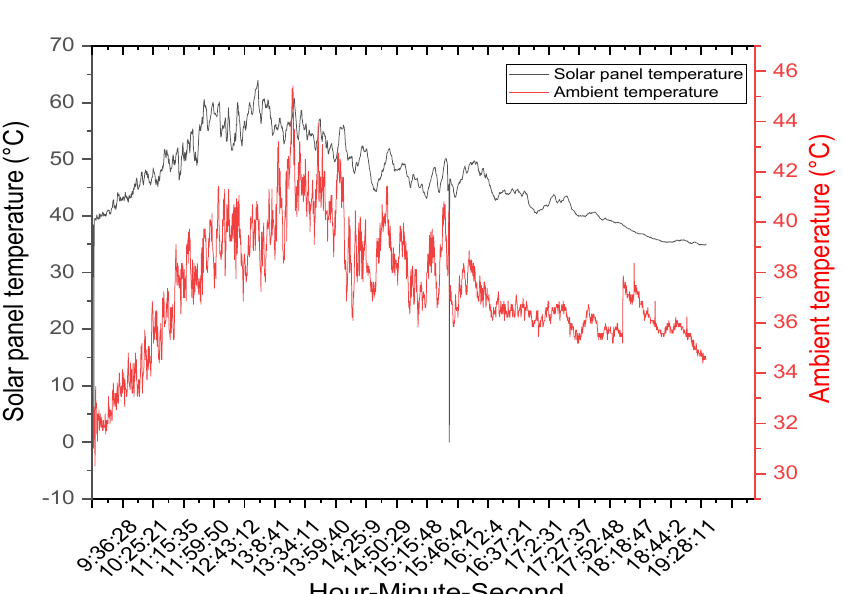
Figure 6b: Variation of the temperature of the solar modules and the ambient temperature